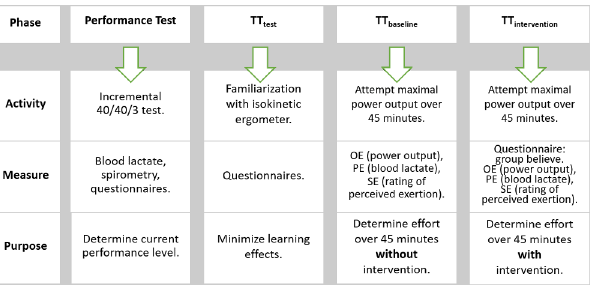
Fig 2. Overview of experimental procedure. OE, objective effort; PE, physiological effort; SE, subjective effort.